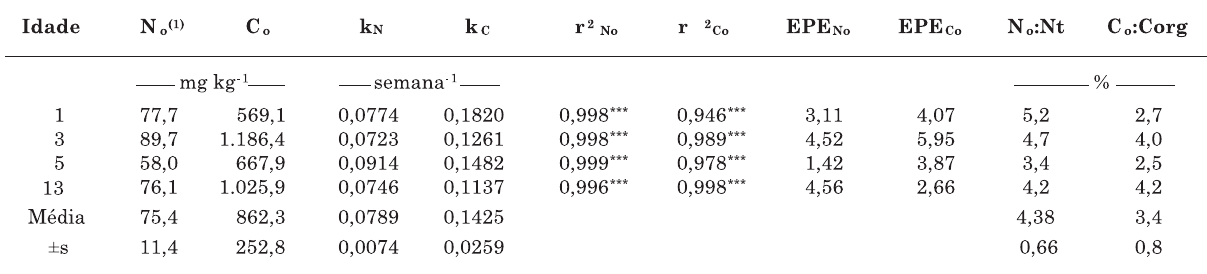
Quadro 6. Nitrogênio e C potencialmente mineralizáveis, constantes de mineralização, obtidas por ajuste de modelo exponencial simples (Stanford & Smith, 1972), e relações entre potenciais de mineralização e características químicas de solos amostrados em plantações de eucalipto de diferentes